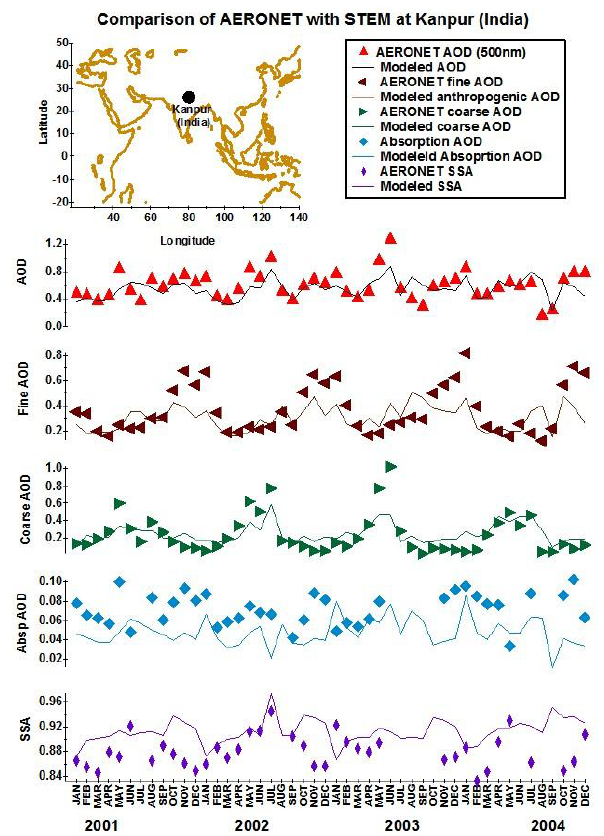
Figure 6. Comparison of AERONET products with the simulated values at Kanpur India Fig. 6. Comparison of AERONET products with the simulated during the 2001-2004 study period. All the AERONET products except SSA and AAOD are values at Kanpur India during the 2001–2004 study period. All obtained at 500nm. The observed AAOD and SSA are interpolated values. The modeled values the AERONET products except SSA and AAOD are obtained at are obtained at 550 nm. The modeled anthropogenic AOD denotes sum of SO4+BC+OC AODs. 500nm. The observed AAOD and SSA are interpolated values. The modeled values are obtained at 550nm. The modeled anthro- pogenic AOD denotes sum of SO4+BC+OC AODs.